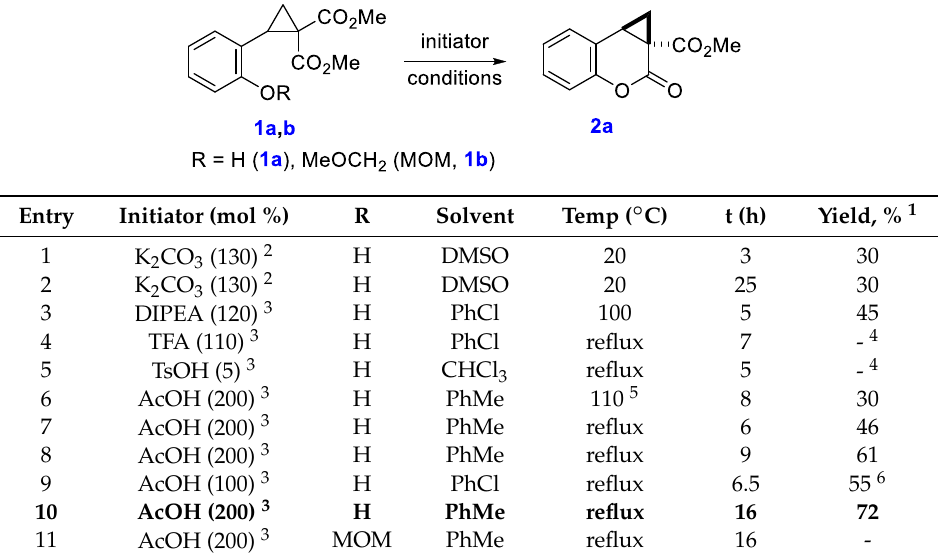
Table 1. Optimization of reaction conditions for the intramolecular transesterification of model cyclopropanes 1a , b .